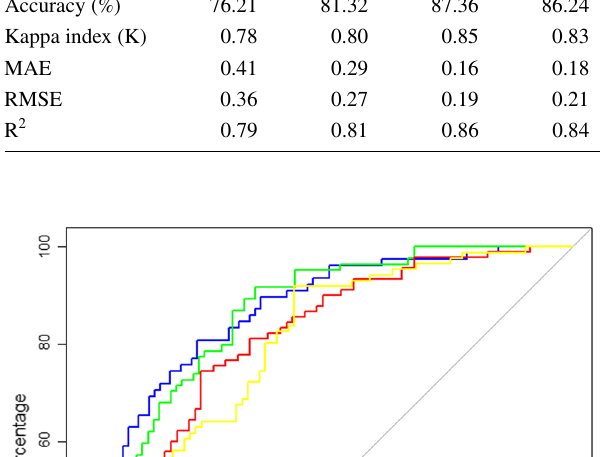
Table 8 The accuracy assessment of AHP, FR, NB and RF model for training and testing data using error measures Methods